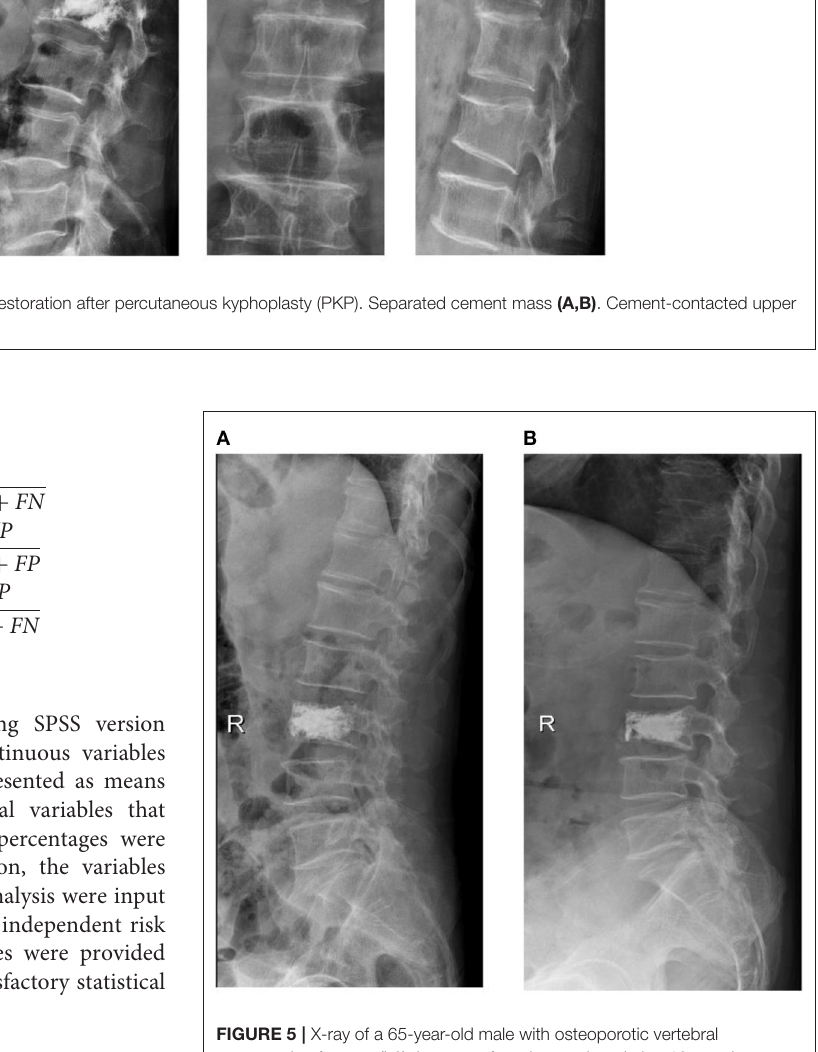
FIGURE 5 | X-ray of a 65-year-old male with osteoporotic vertebral compression fracture (L3), he was referred to our hospital at 10 months postoperatively for low back pain and was diagnosed with